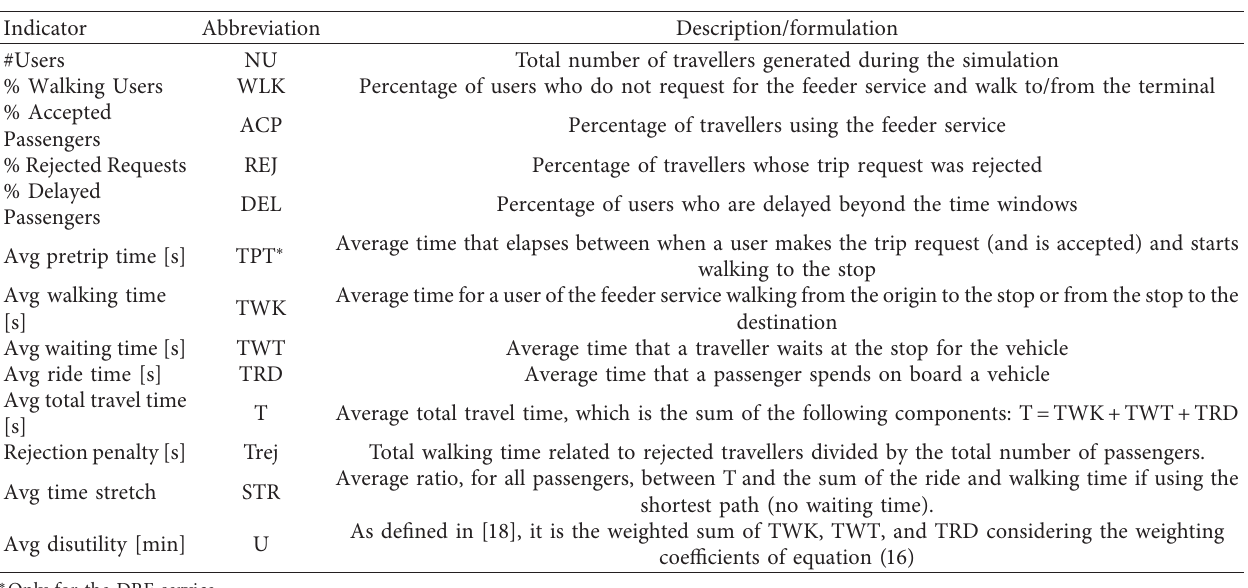
Table 1: Description of the user-related output